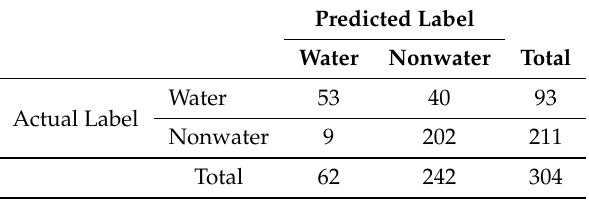
Table 2. Confusion Matrix Before Test Set Rectification.